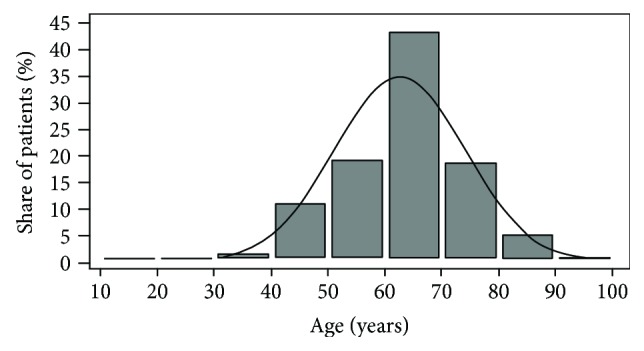
Age distribution of patients involved in the study (n = 418); the dotted line represents theoretical normal distribution with the empirically obtained arithmetic mean age.